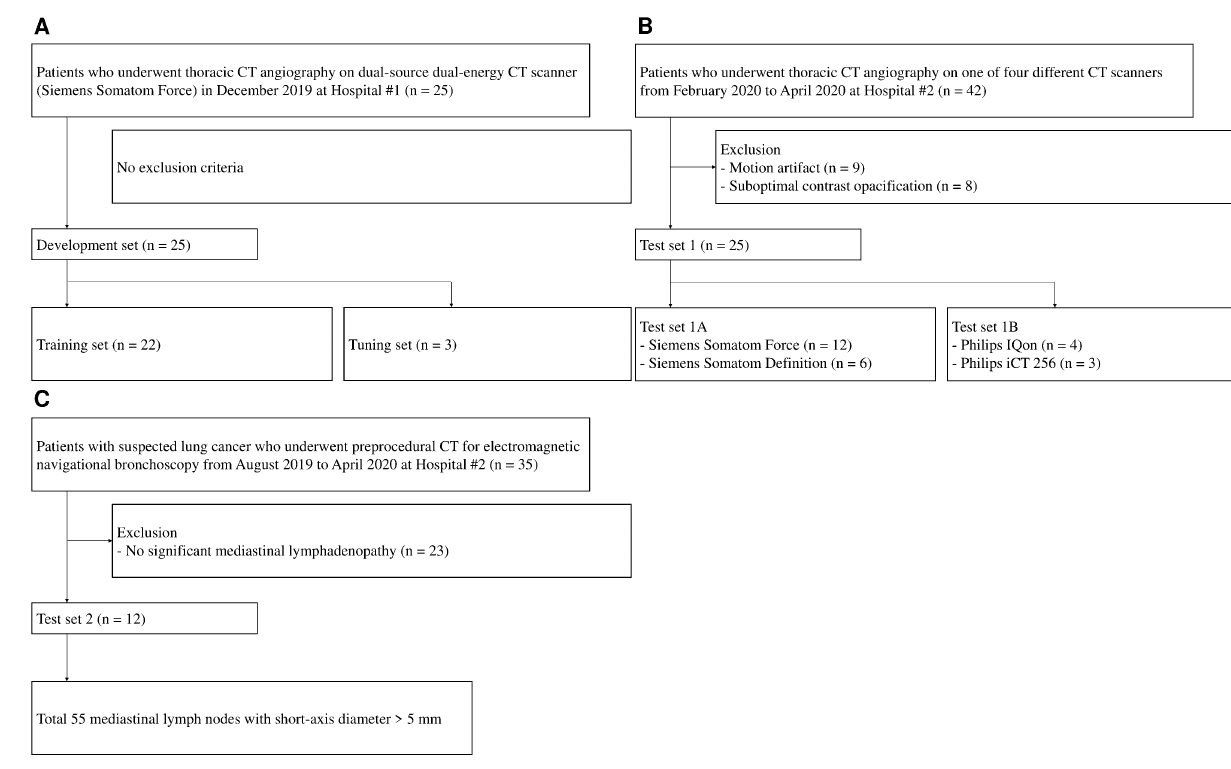
Figure 1. Flowchart depicting patient inclusion and exclusion. Development set ( A ), test set 1 ( B ), and test set 2 ( C